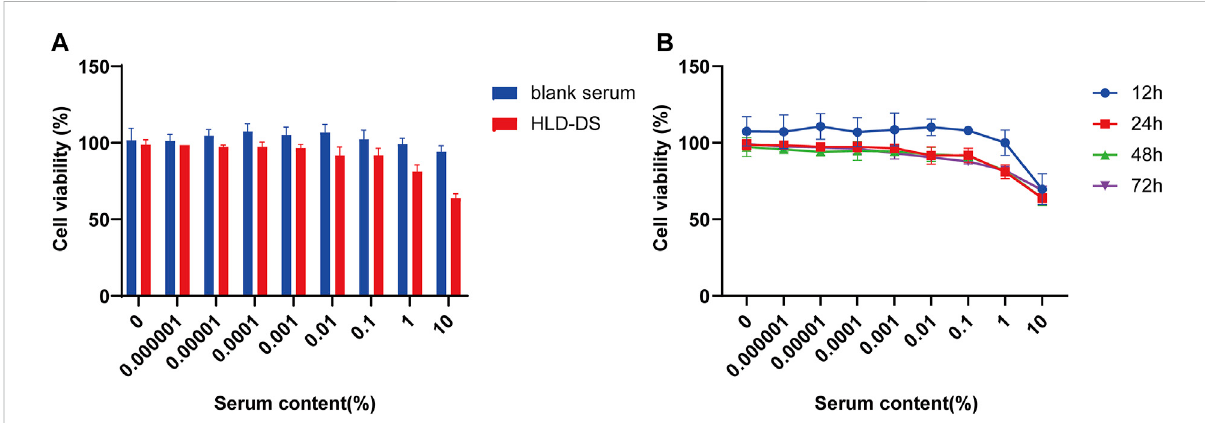
FIGURE 6 HLD-DS CCK-8 experiment. The cytotoxicity of NCM460 cells treated by HLD-DS was investigated by the CCK-8 assay. (A) Effects of serial concentrations of HLD-DS on cell viability. (B) The effect of 1% HLD-DS on cell viability at 12, 24, 48, and 72 h. All data are presented as mean ± SD. ( n =